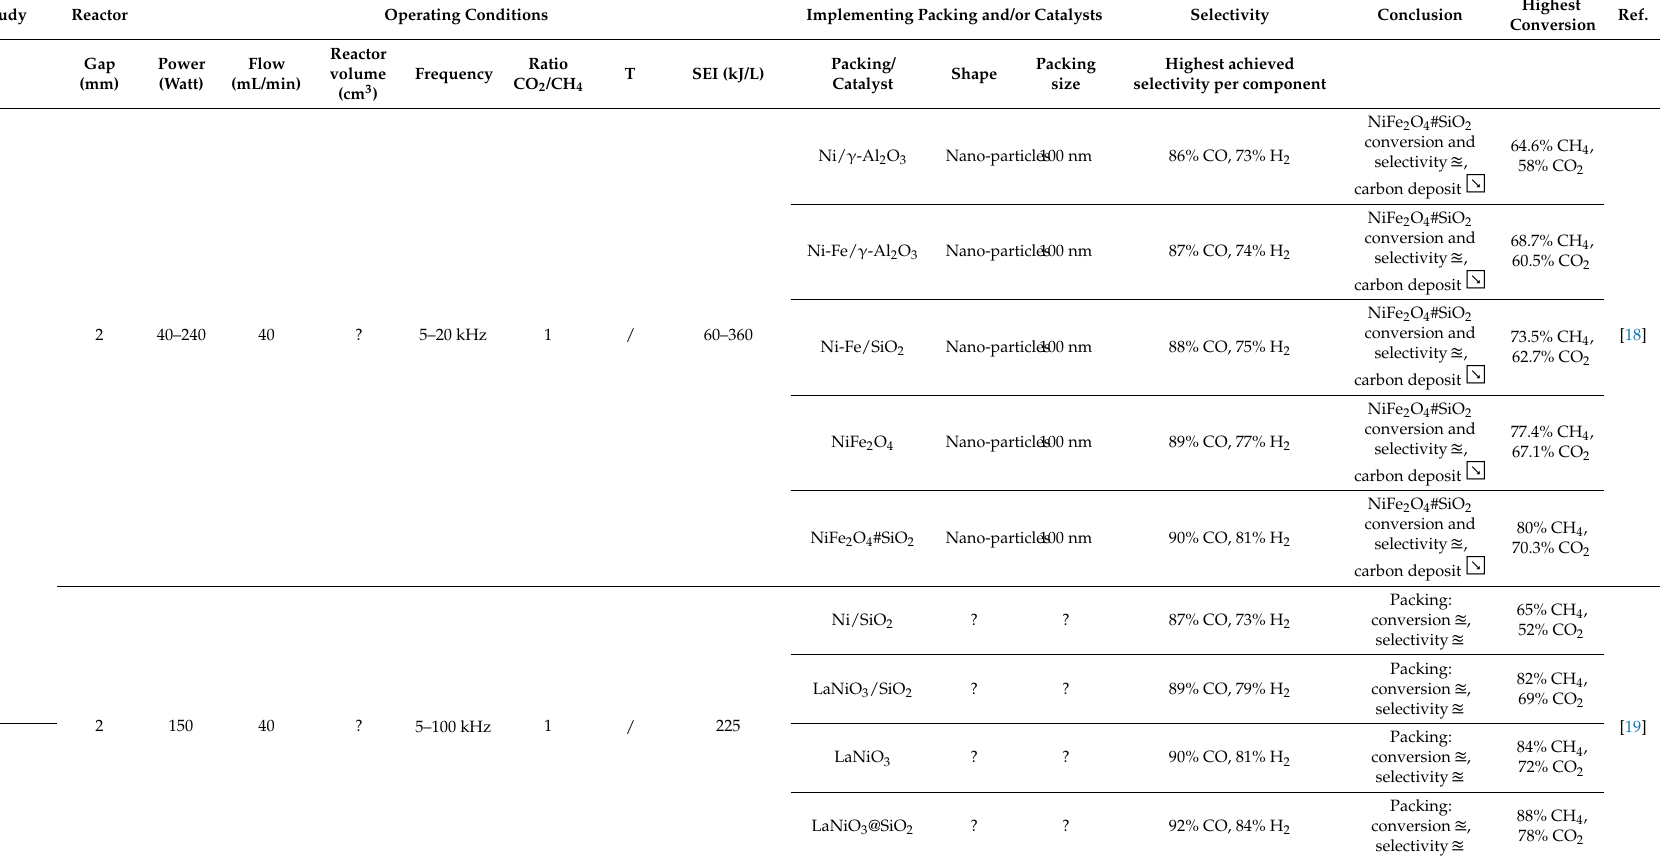
Table 2. Cont. Table 1. Summary of a selection of literature for CO 2 splitting in a non-packed and a packed DBD reactor.